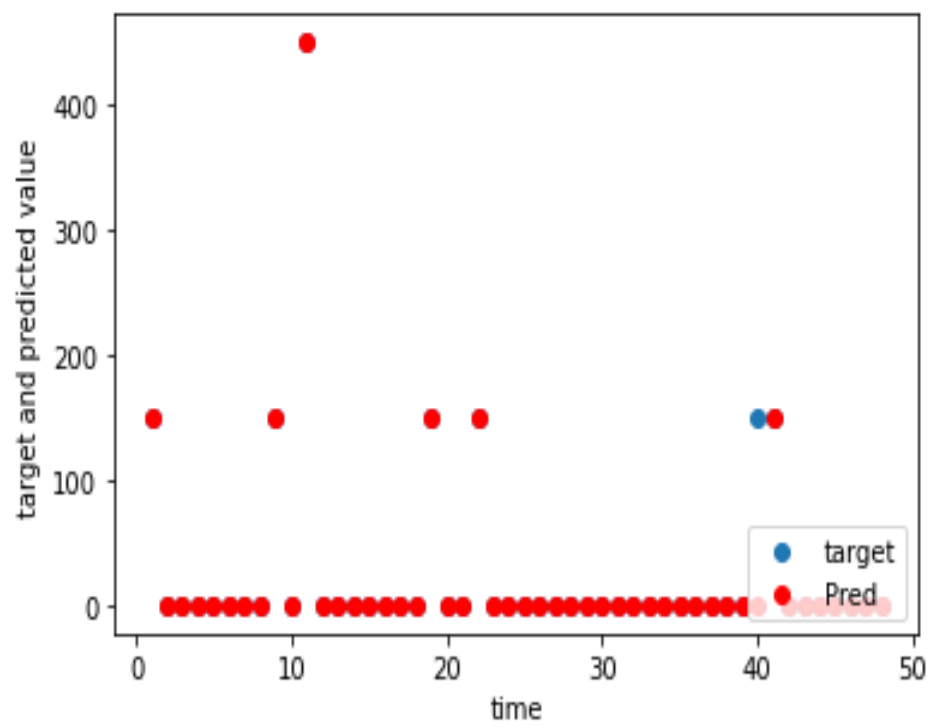
Figure 15. Charging demand prediction of a weekday for Alakaupunki.